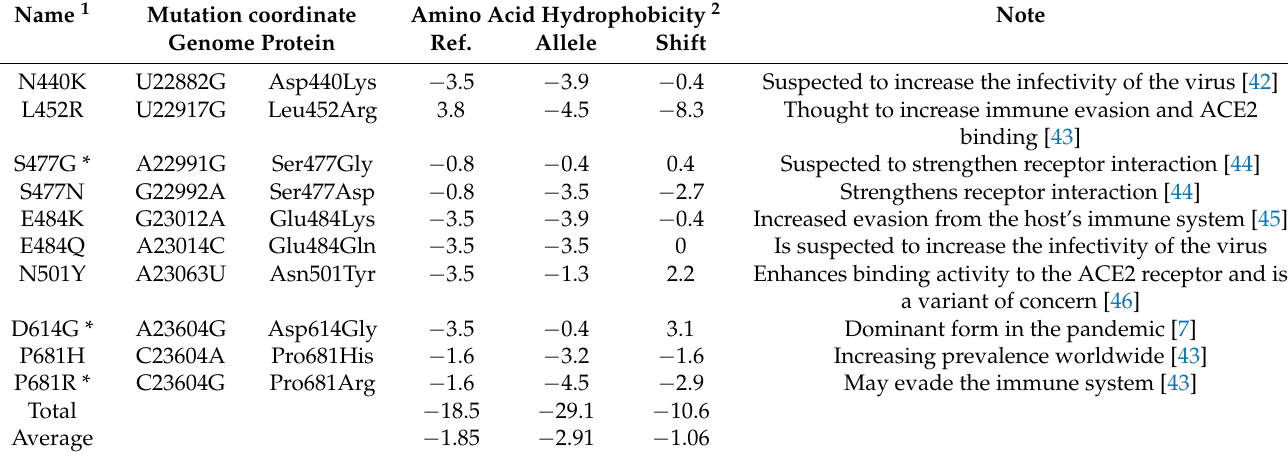
Table 2. Biochemical characteristics of amino acids containing major S-protein variants involved virus infectivity and